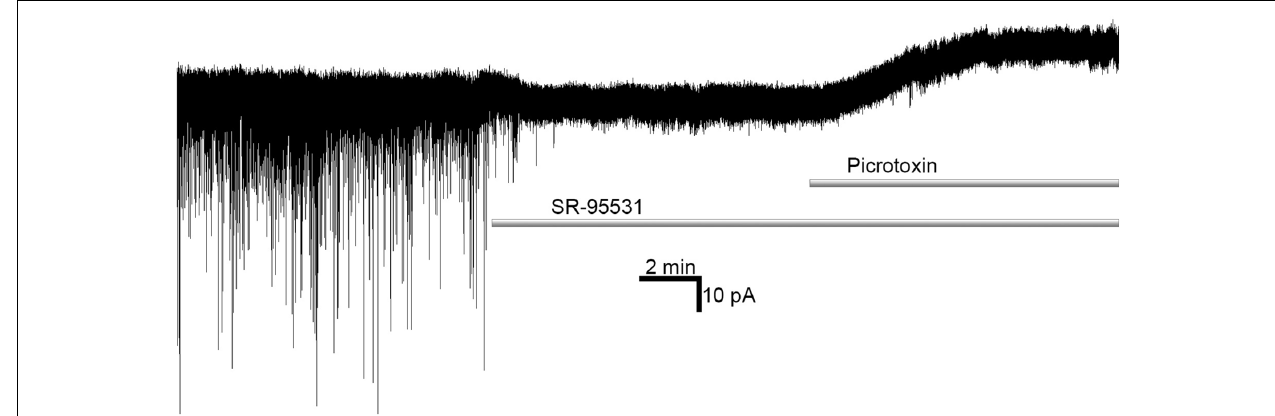
FIGURE 1 | Competitive γ -aminobutyric acid (GABA) antagonist SR-95531 suppresses spontaneous GABA-ergic synaptic signaling, but does not affect tonic conductance; on the contrary, open-channel blocker picrotoxin applied after SR-95531 shuts spontaneously opening GABA-receptors (s-GABA A Rs), revealing the amount of inhibitory current passing through s-GABA A Rs independently of GABA